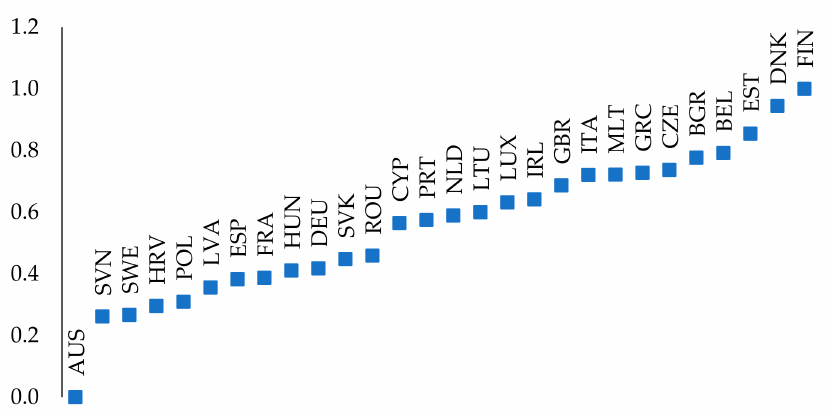
Figure A1. Linear ordering of the EU countries on the basis of coefficients of linear trends.